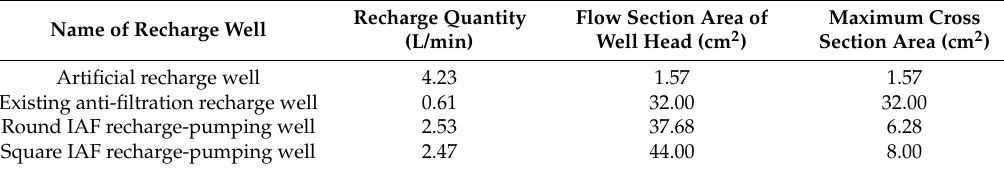
Figure 7. Measured value of the groundwater level. Table 1. Results of the laboratory steady-state flow recharge test.